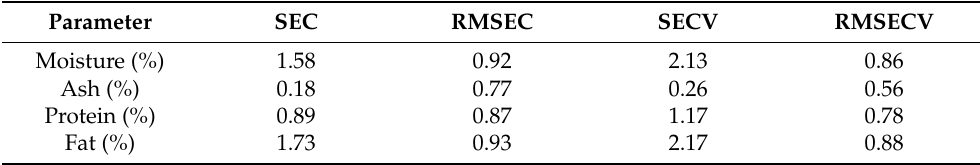
Figure 1. Near infrared spectra of traditional sausages. Table 2. Calibration statistics for estimating the chemical composition of traditional sausages for the calibration samples.